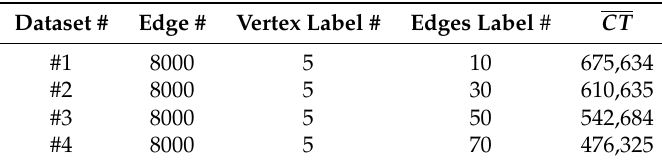
Table 5. Experimental results on the increasing number of edge